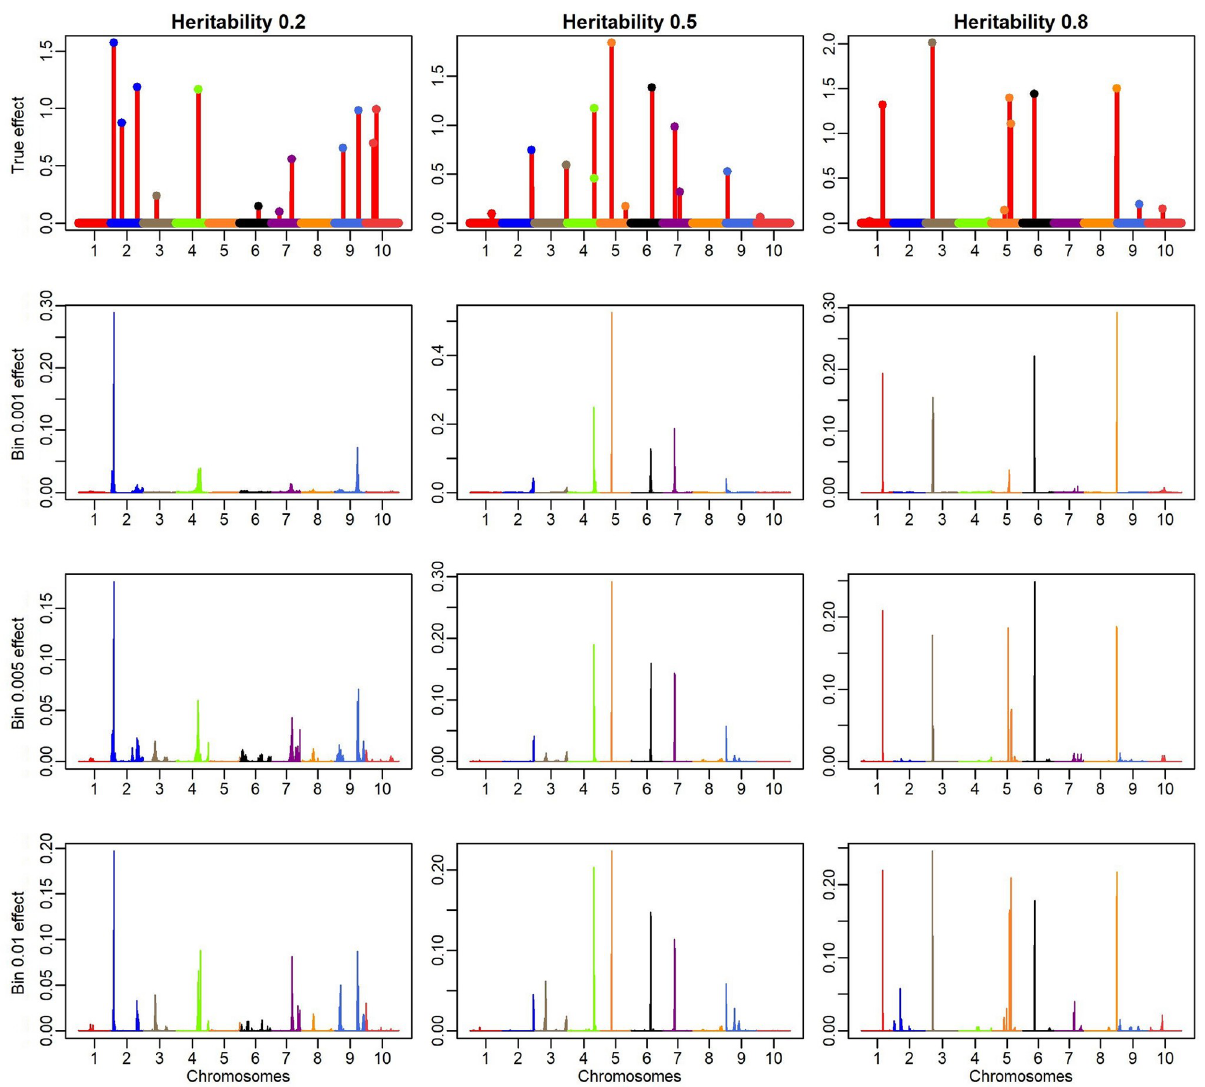
Fig 3. Absolute simulated actual effects of QTL along the genome and absolute estimates from the methods for Bin 0.001, Bin 0.005 and Bin 0.01. Colored dots represent the 12 true QTL, which are distributed across 12,150 SNP over 10 linkage groups. There is a scale